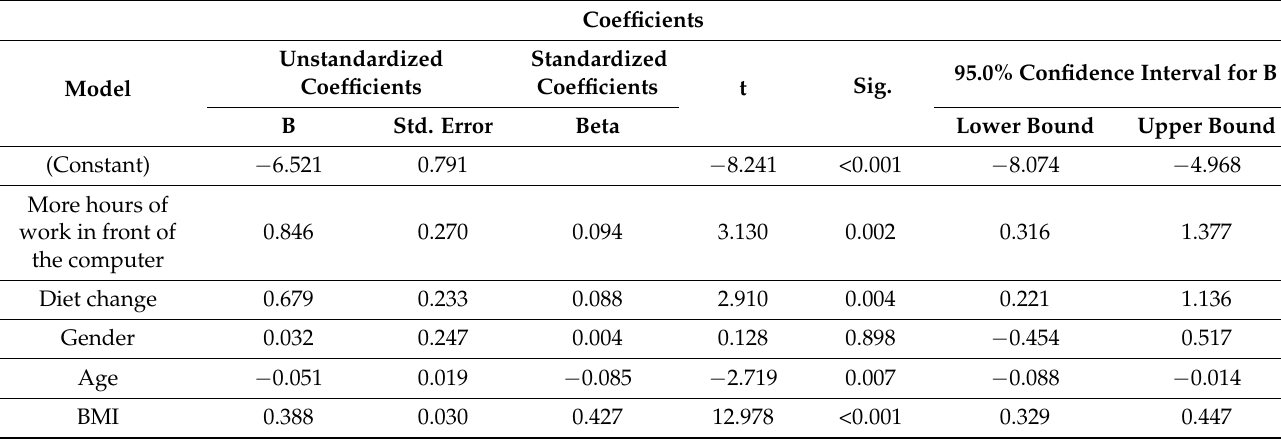
Table 11. Multiple regression regarding the weight gain during the